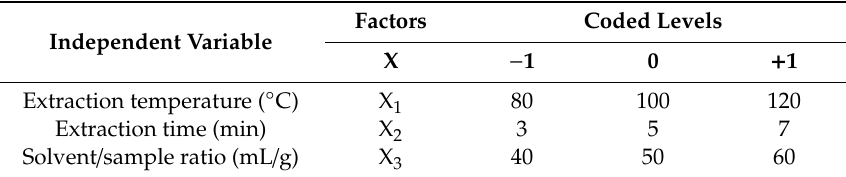
Table 1. Independent process variables, range, and levels used for Box–Behnken design. Factors Coded Levels Independent Variable X − 1 0 +